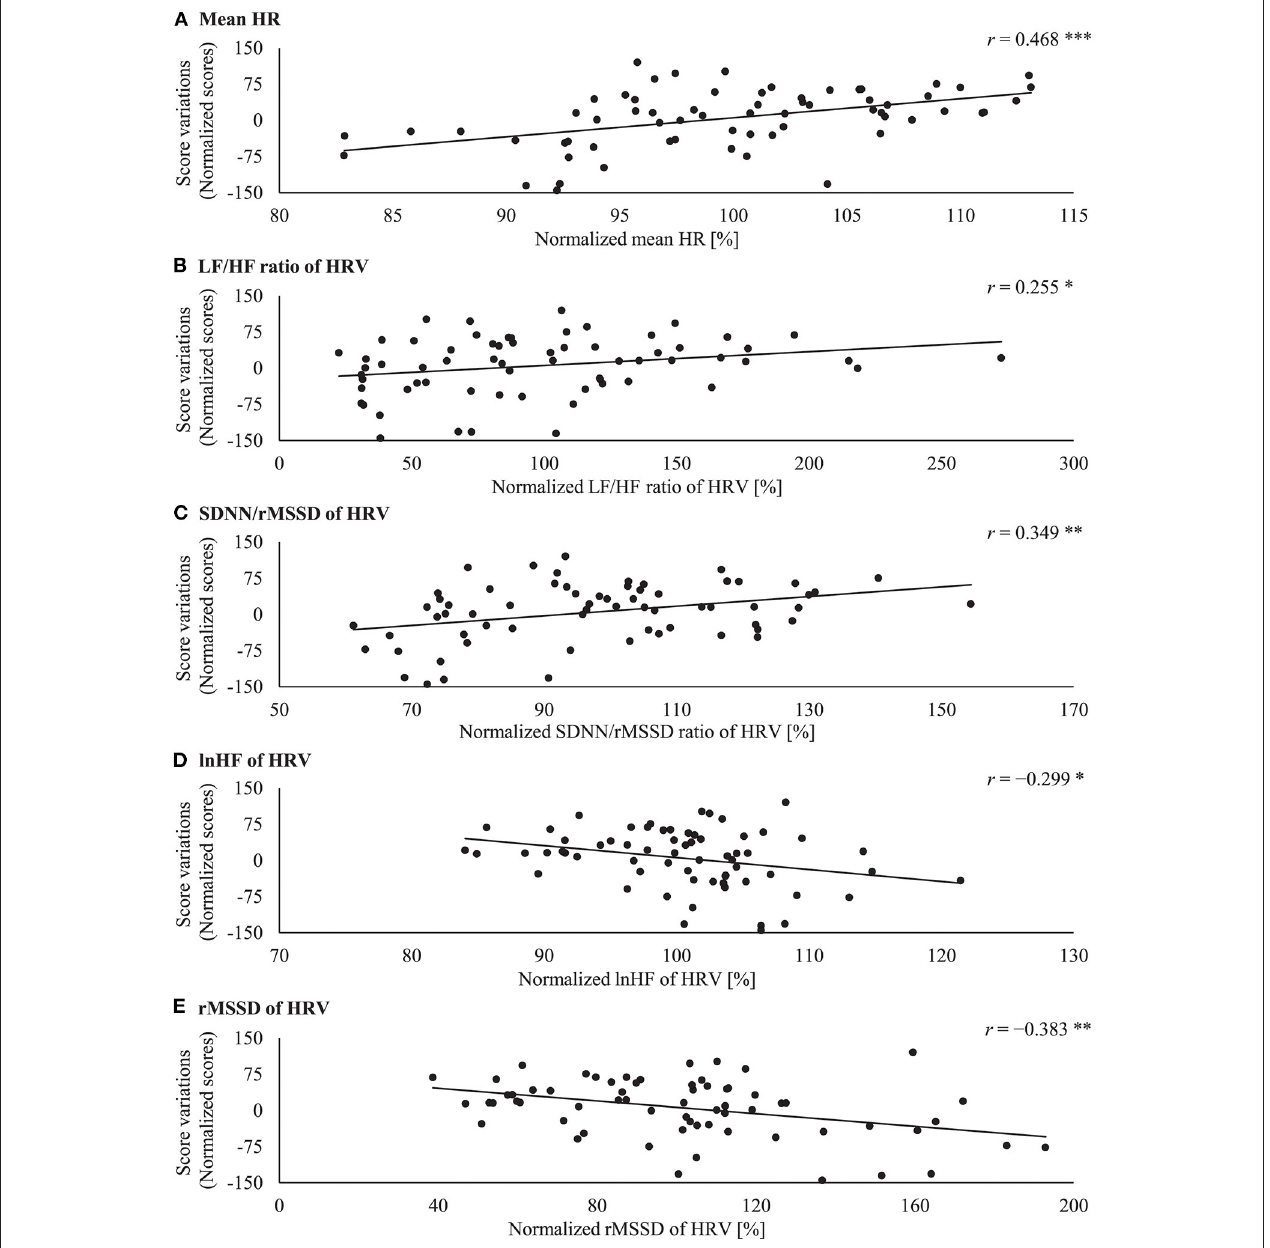
FIGURE 2 | Correlations between normalized score variations and (A) mean HR, (B) LF/HF ratio of the HRV, (C) SDNN/rMSSD ratio of the HRV, (D) lnHF component of the HRV, and (E) rMSSD of the HRV. The vertical axis indicates score variations (the difference between the points scored in each of the three sessions and the average score for all sessions for each participant). The scores, including score variations, are given as points. The horizontal axis indicates the normalized physiological data (percentage of the average values for all sessions for each participant). The solid line indicates a linear regression line for the data. There are 65 data points in each graph. Statistical significance is indicated as follows: * p < 0.05, ** p < 0.01, *** p <